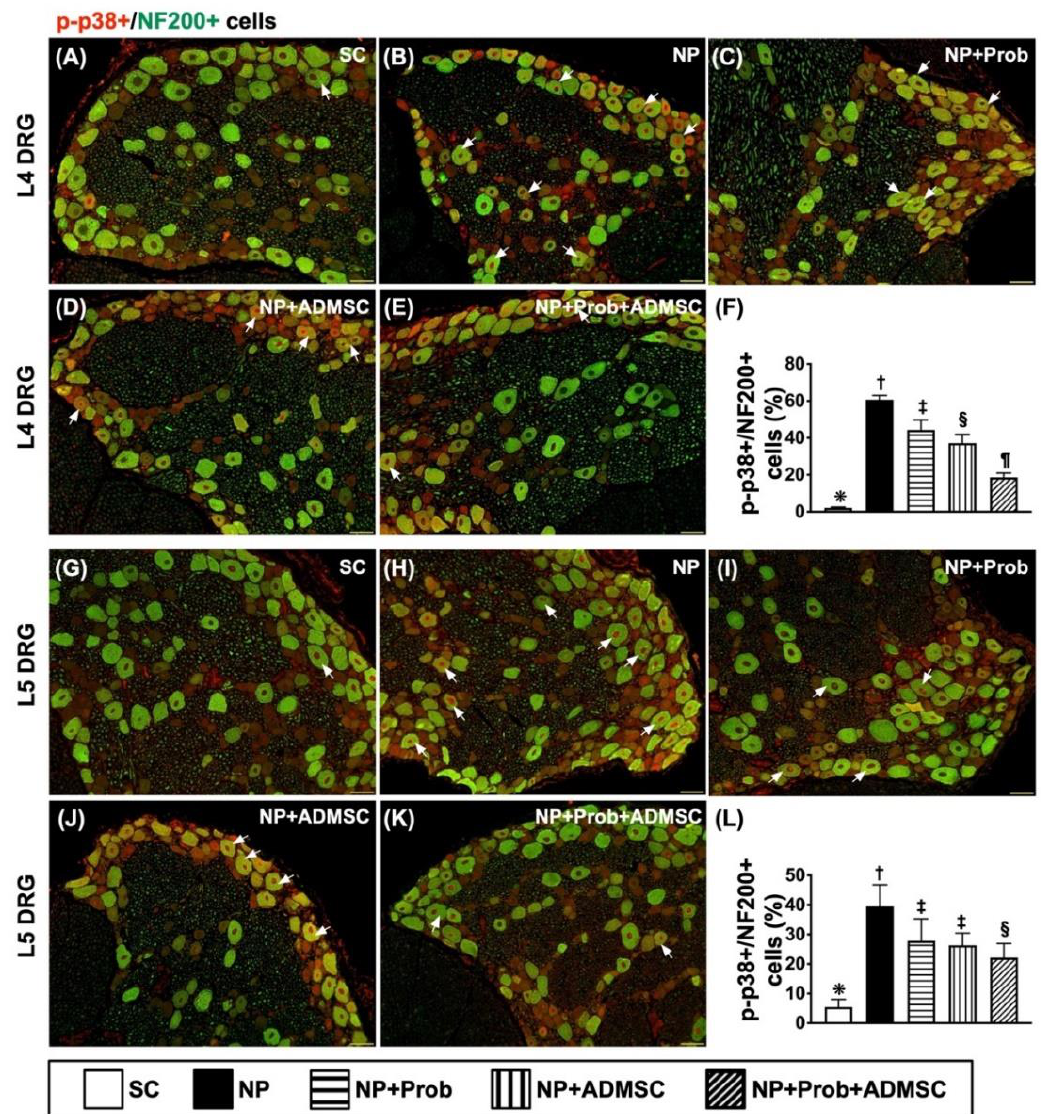
Figure 9. Immunofluorescent microscopic evaluation for identification of co-localization of p-P38 and NF200 in L4-5 DRGs neurons by day 60 after NP induction L4-DRG level: ( A – E ) Illustrating the immunofluorescent (IF) microscopic findings (200 × ) to identify merged positively stained p-P38 and NF200 (green–red co-localization). ( F ) Analytical results of number of p-P38+/NF200+ cells, * vs. other groups with different symbols (†, ‡, §, ¶), p < 0.0001. L5-DRG level: ( G – K ) Illustrating IF microscopic findings (200 × ) to identify merged positively stained p-P38 and NF200 (green–red co-localization). ( L ) Analytical results of number of p-P38+/NF200+ cells, * vs. other groups with different symbols (†, ‡, §, ¶), p < 0.0001. Note that the white arrows indicate the merged double stain of p-P38+/NF200+. Scale bars in the lower-right corner represent 50 µ m. Symbols (*, †, ‡, §, ¶) indicate significance for each other (at the 0.05 level). All statistical analyses were performed using one-way